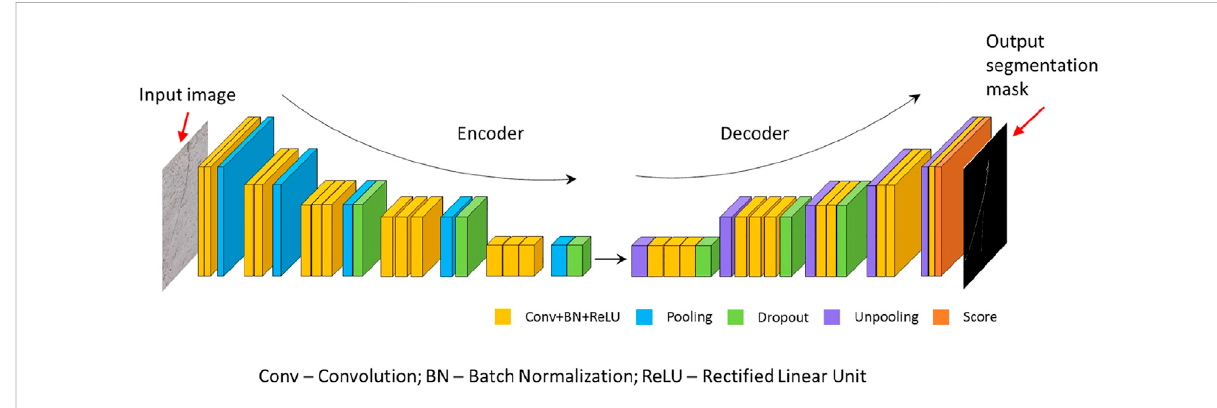
FIGURE 6 Typical encoder-decoder-based fully convolutional network architecture for defect